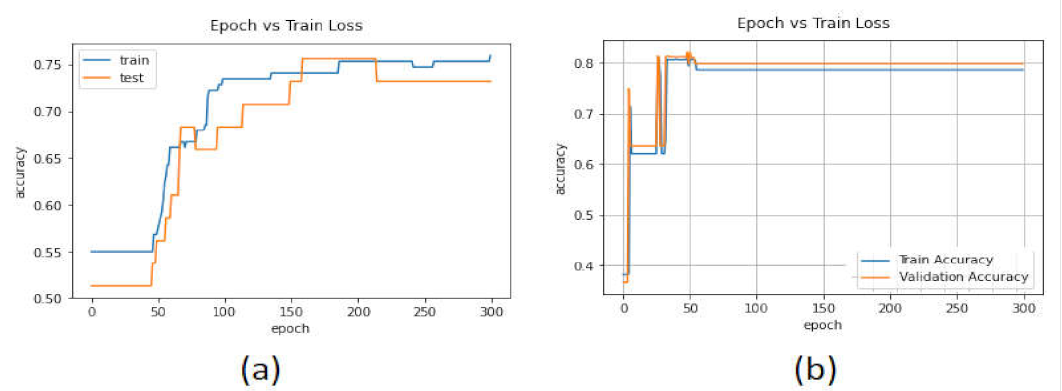
Figure 17. Accuracy of the AE model in the ( a ) CICAndMal2017 and ( b ) Drebin datasets. Figure 18 display the accuracy loss of the AE model in both datasets. The accuracy loss